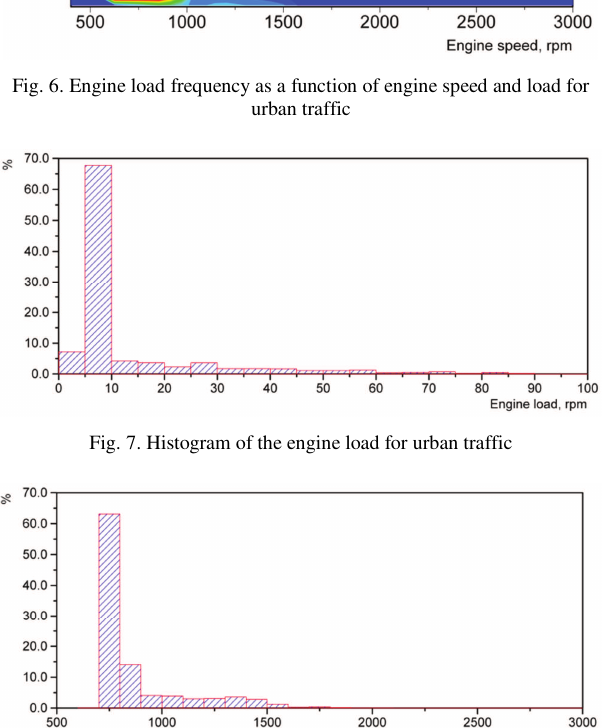
Fig. 9. Engine load frequency as a function of engine speed and load for non-urban traffic